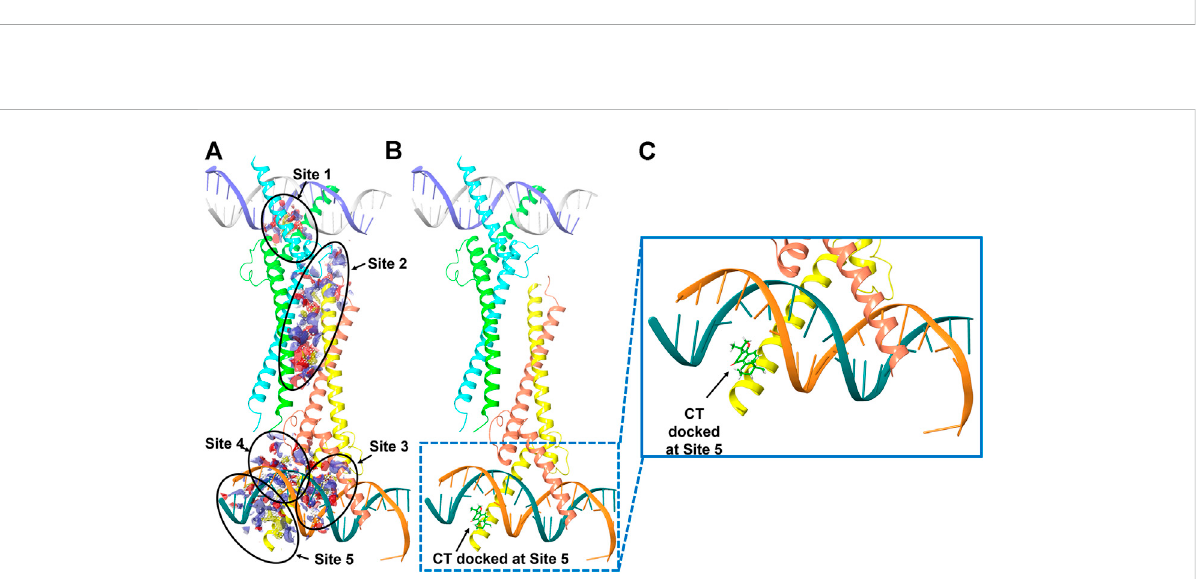
Molecular modeling of CT and c-Myc/Max. (A) Five predicted potential binding sites in the Myc-Max-DNA complex (PDB ID 1NKP). (B) Binding pose of CT docked in the complex that has the best docking score. (C) Zoom-in view of the binding pose. Subunits of Myc proto-oncogene protein are labeled in green and orange. Subunits of Max protein are labeled in cyan and